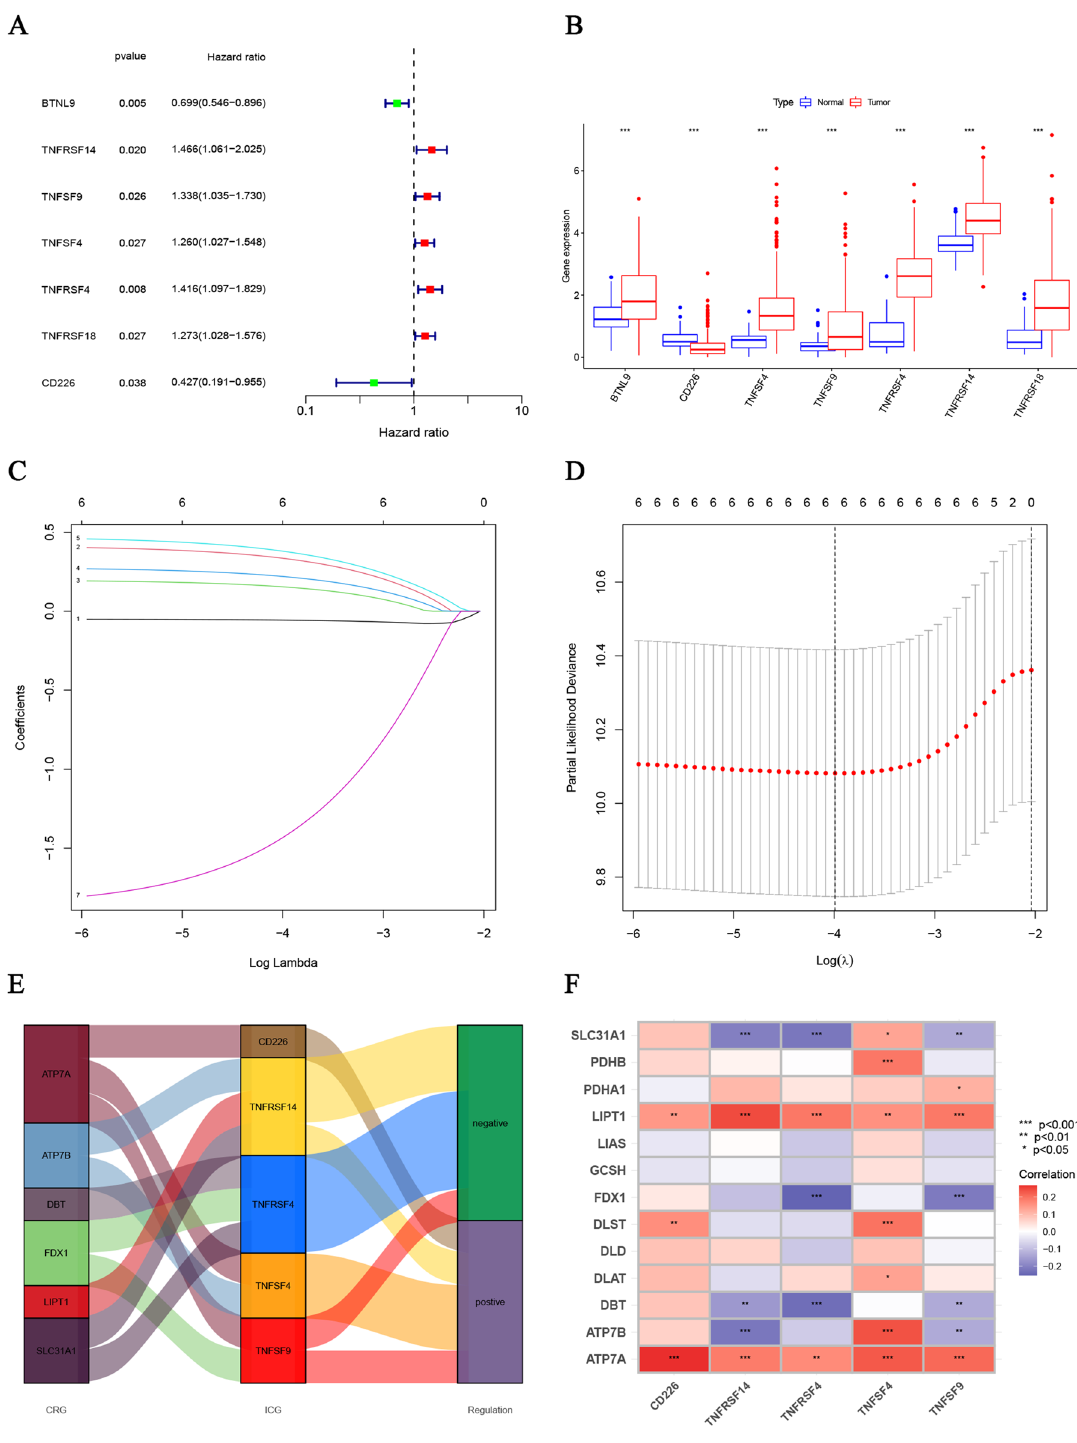
Figure 2. Construction of cuproptosis ‐ related ICGs. ( A , B ) The expression profiles of 7 ICGs preliminarily screened by univariate Cox regression analysis. ( C , D ) The cvfit and lambda curves performed by the LASSO regression model. ( E , F ) The Sankey diagram and the correlation heatmap of prognostic cuproptosis ‐ related ICGs screened by the multivariate Cox regression